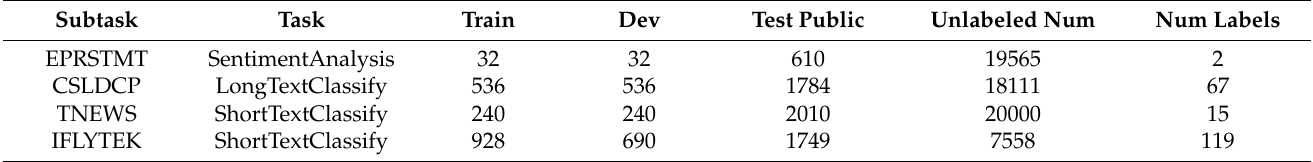
Table 1. Task description and statistics of the FewCLUE